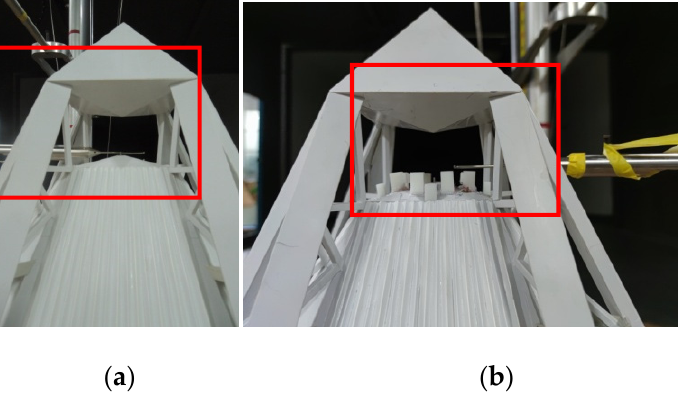
Figure 8. Details of the hollow-layer plane: ( a ) case 1 with instrument absence; ( b ) case 2 with instrument presence.